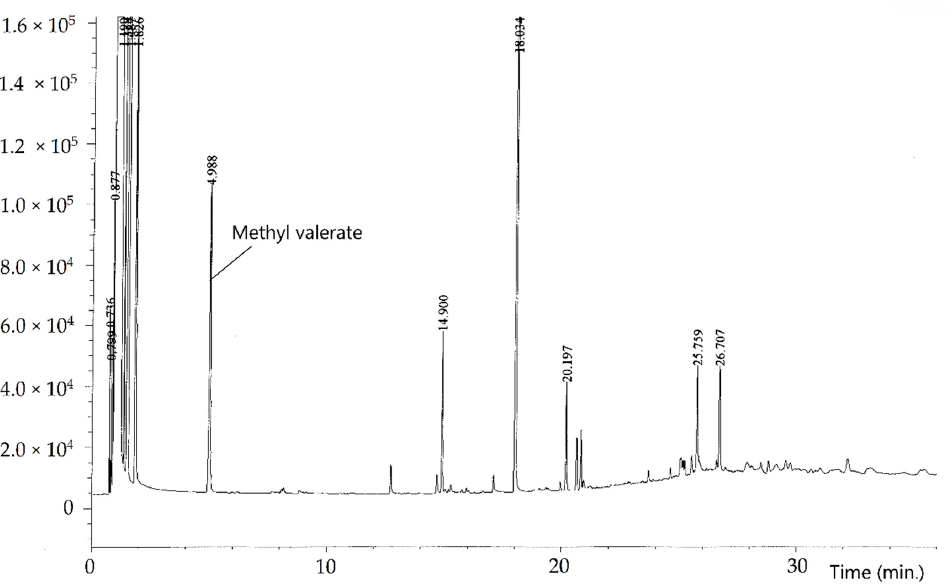
Figure 4. Gas chromatogram of the reaction mixture of tetramethylammonium